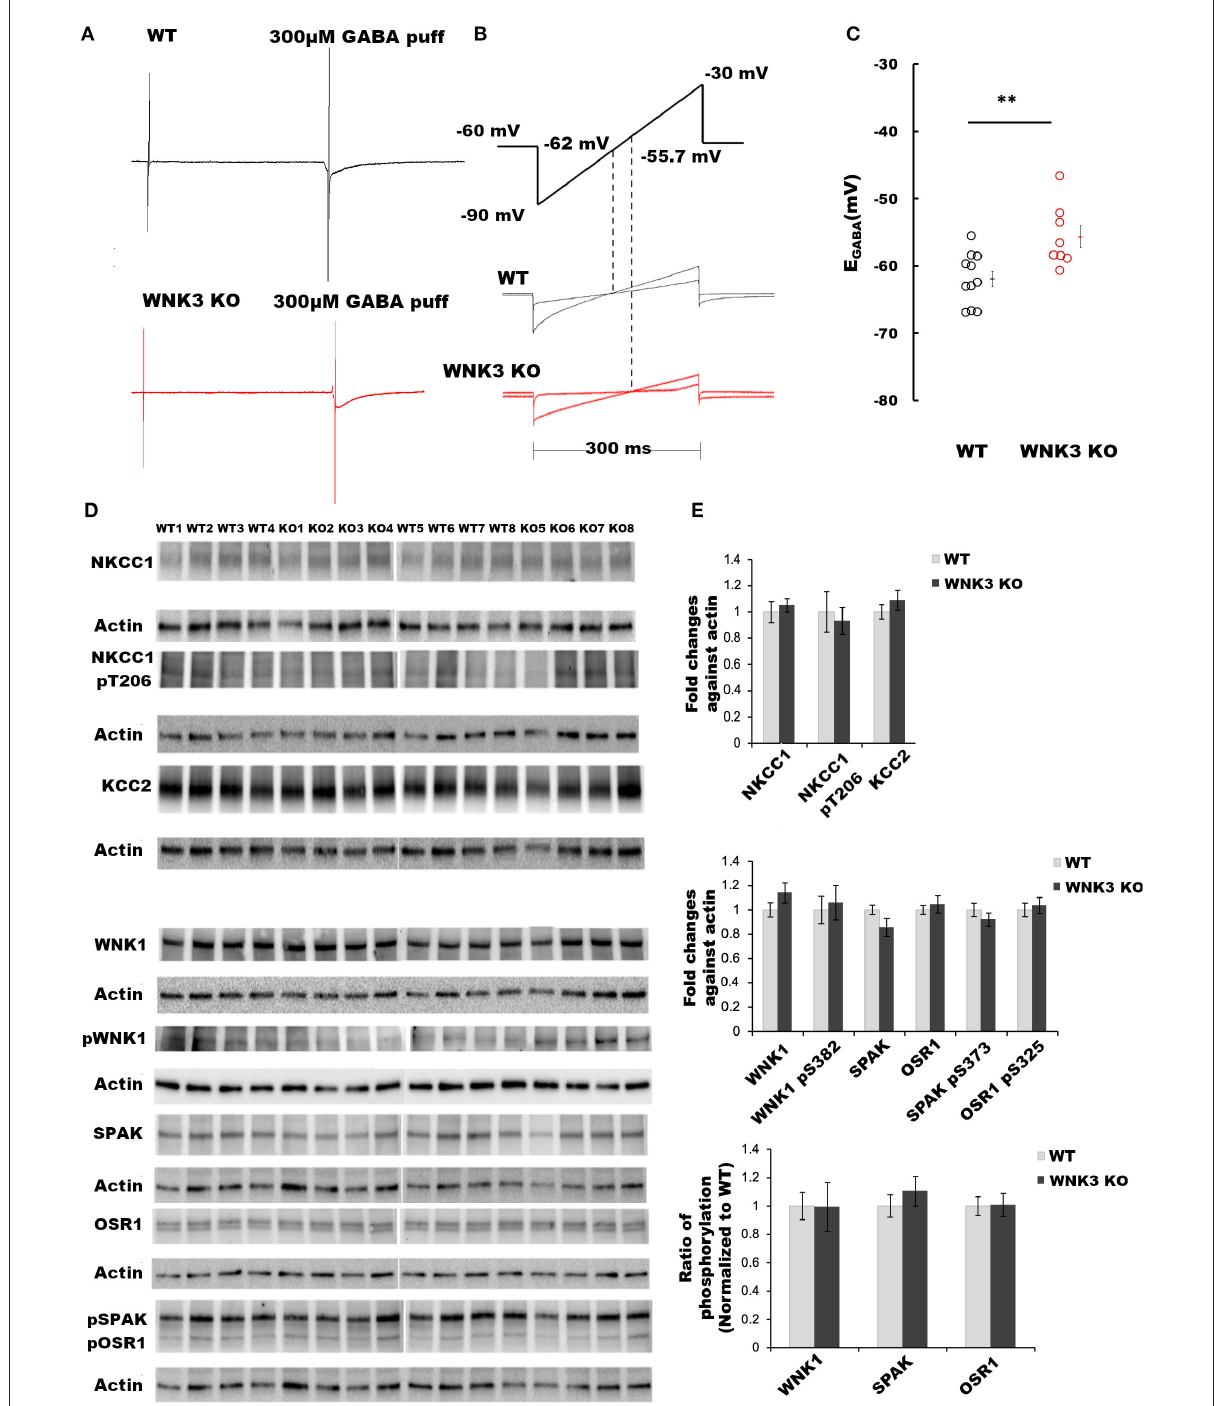
FIGURE1 WNK 3 loss depolarizes GABA reversal potential in layer V pyramidal neurons at postnatal day 21. (A) Gramicidin-perforated patch recordings showing current traces in WT (black) and WNK3 KO neurons (red). The voltage ramps were applied before and during 300 µ M GABA application to determine the GABA reversal potential (E GABA ). The rise and decay phase of the current response to GABA puff application were unchanged by the ramp protocol (B) . Voltage ramp protocol was performed to determine E GABA (upper panel). The holding voltage was clamped at − 60mV. Two voltage ramps starting from − 90mV to − 30mV of 300ms duration in the absence and presence of GABA (1s) were applied. The middle and lower panels show representative current responses to these two ramp protocols in WT (black) and WNK3 KO neurons (red), respectively. Dashed lines indicate the corresponding voltage level at which the two responses intersect indicating the E GABA values. (C) Quantitative analysis